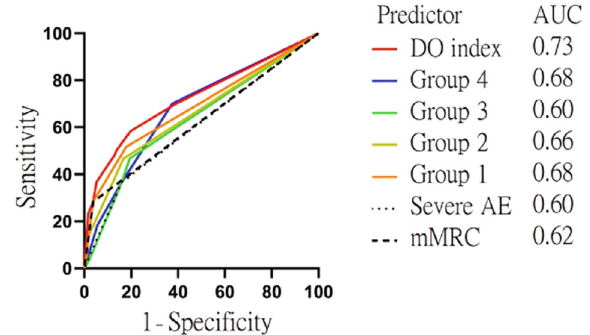
Fig. 1 ROC curve for severe dyspnea, severe acute exacerbation, and different combinations of predictors and DO index for 1-year mortality in COPD patients. The AUC values for patients with severe dyspnea (mMRC = 4), frequent severe AE, groups 1 – 4, and DO index were 0.62, 0.60, 0.68, 0.66, 0.60, 0.68, and 0.73, respectively.